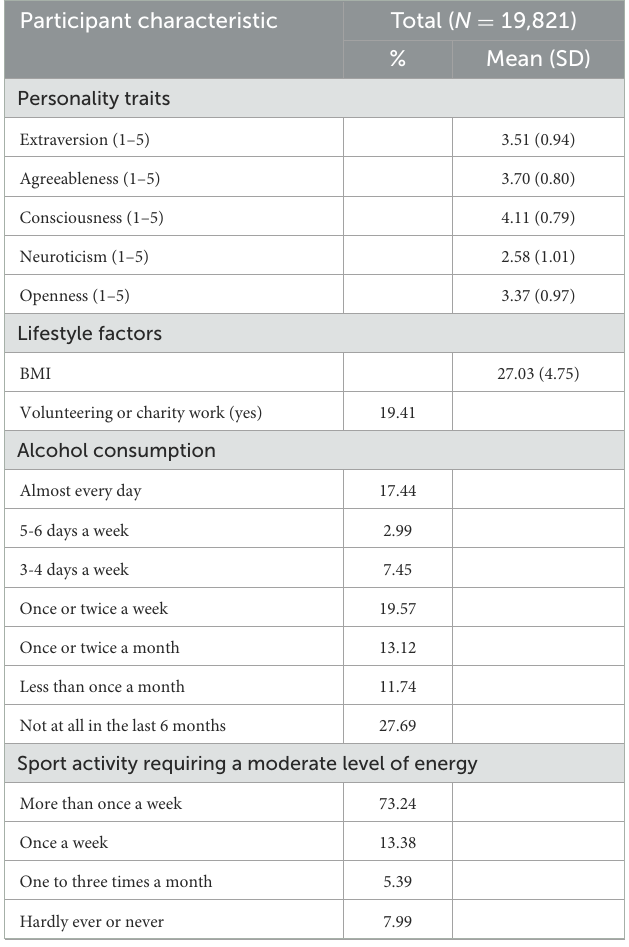
TABLE 1 Distribution of participant characteristics at the study prebaseline wave (wave 4, N =